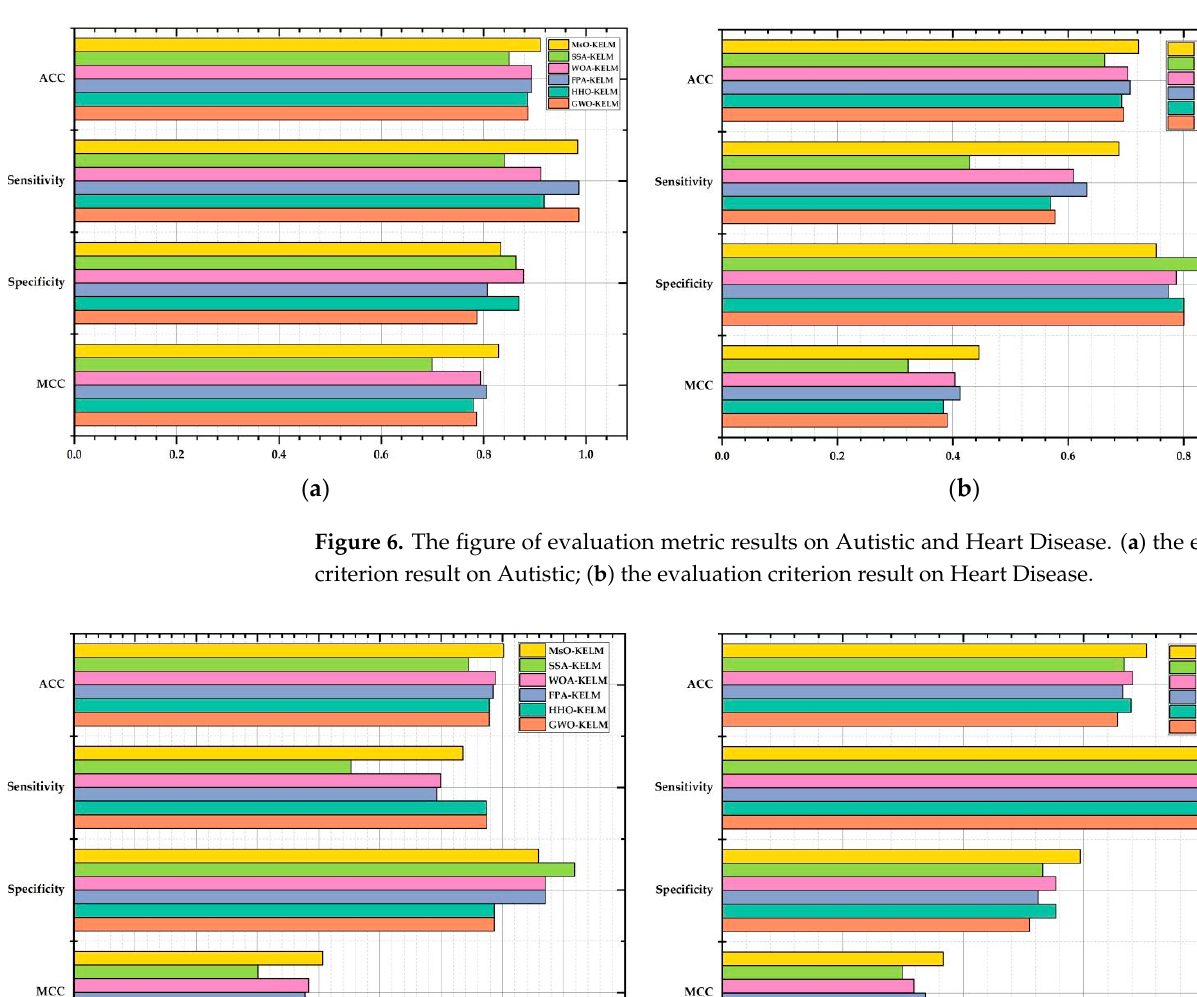
Figure 5. The figure of evaluation metric results on Breast Cancer and Parkinson. ( a ) the evaluation criterion result on Breast Cancer; ( b ) the evaluation criterion result on Parkinson.